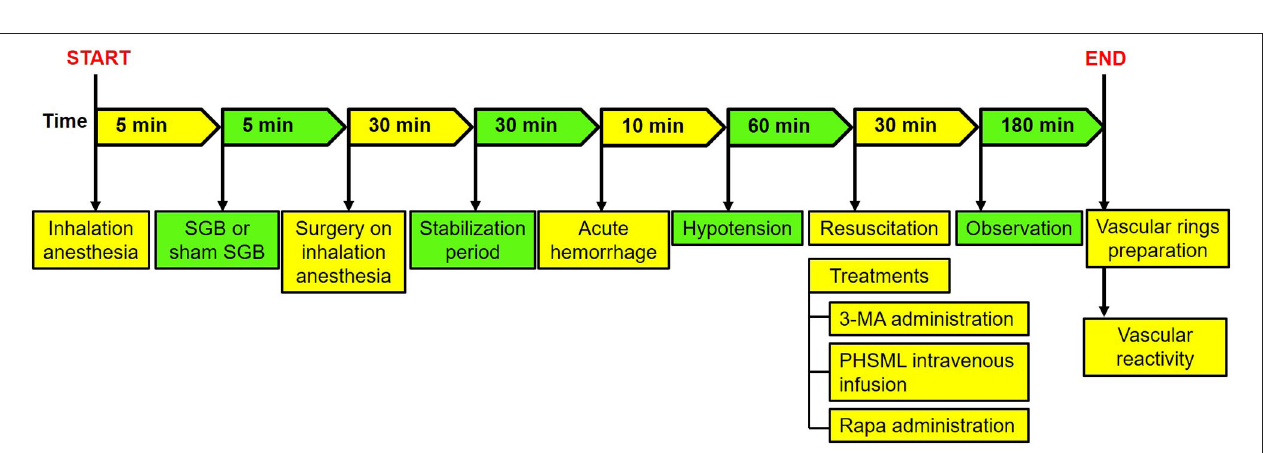
injected by a posterior percutaneous approach. After isoflurane inhalation withdraw for about 5 min, then the rats naturally awakened, the right droopy eyelid was used as a positive sign of SGB successfully. To Sham SGB, the same procedures were performed except for injecting the same amount of